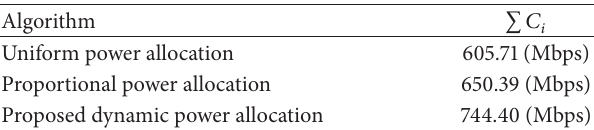
Table 3: Total system capacity for the three algorithms in Scenario